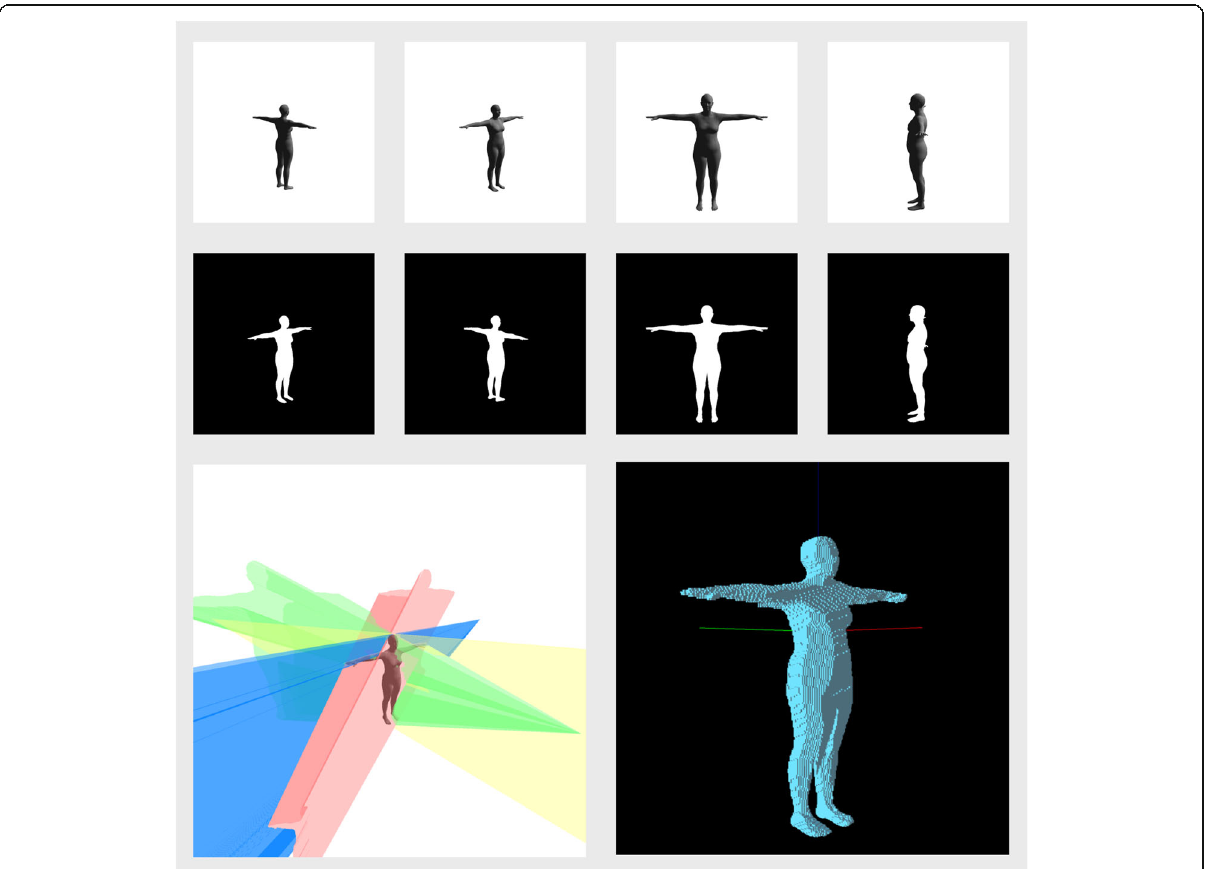
Fig. 7 The generation of a visual hull, which is a type of 3D reconstruction of an object viewed from multiple cameras. Top row: images of an object are captured as 2D images from multiple directions. Middle row: these images are processed to produce silhouette images for each camera. Bottom left: the silhouettes are back-projected from each camera, resulting in cone-like regions of space. Bottom right: the intersection of these cones results in the visual